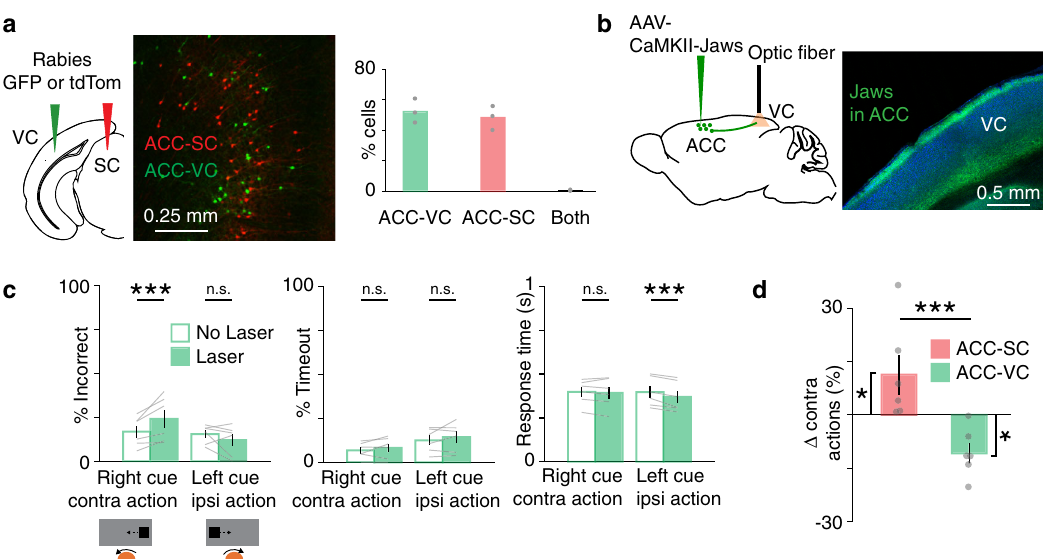
Fig. 5 Effect of ACC-VC inactivation on behavioral performance. a Dual-color retrograde tracing from the visual cortex (VC) and SC (green, GFP; red, tdTomato). Back-labeled ACC neurons projecting to the SC (red) or VC (green). Bar graph shows proportion of back-labeled neurons projecting to either or both areas ( n = 3 mice). b AAV5-CaMKII-Jaws-GFP was injected in the ACC and axons in VC were targeted for inactivation (green, GFP; blue, DAPI). Similar expression was found across the six mice tested. c Behavioral performance for non-laser (un fi lled) and laser ( fi lled) conditions on right cue/ contraversive action and left cue/ipsiversive action trials with inactivation of ACC outputs to the VC ( n = 6 mice). Incorrect performance (right cue, p = 0.002; left cue, p = 0.153), timeouts (right cue, p = 0.204; left cue, p = 0.312) and response time (right cue, p = 0.656; left cue, p = 0.006) are shown. *** p < 0.005; n.s. not signi fi cant. Signi fi cance evaluated with two-tailed permutation test at the Bonferroni-adjusted p value of 0.025. d Comparison of